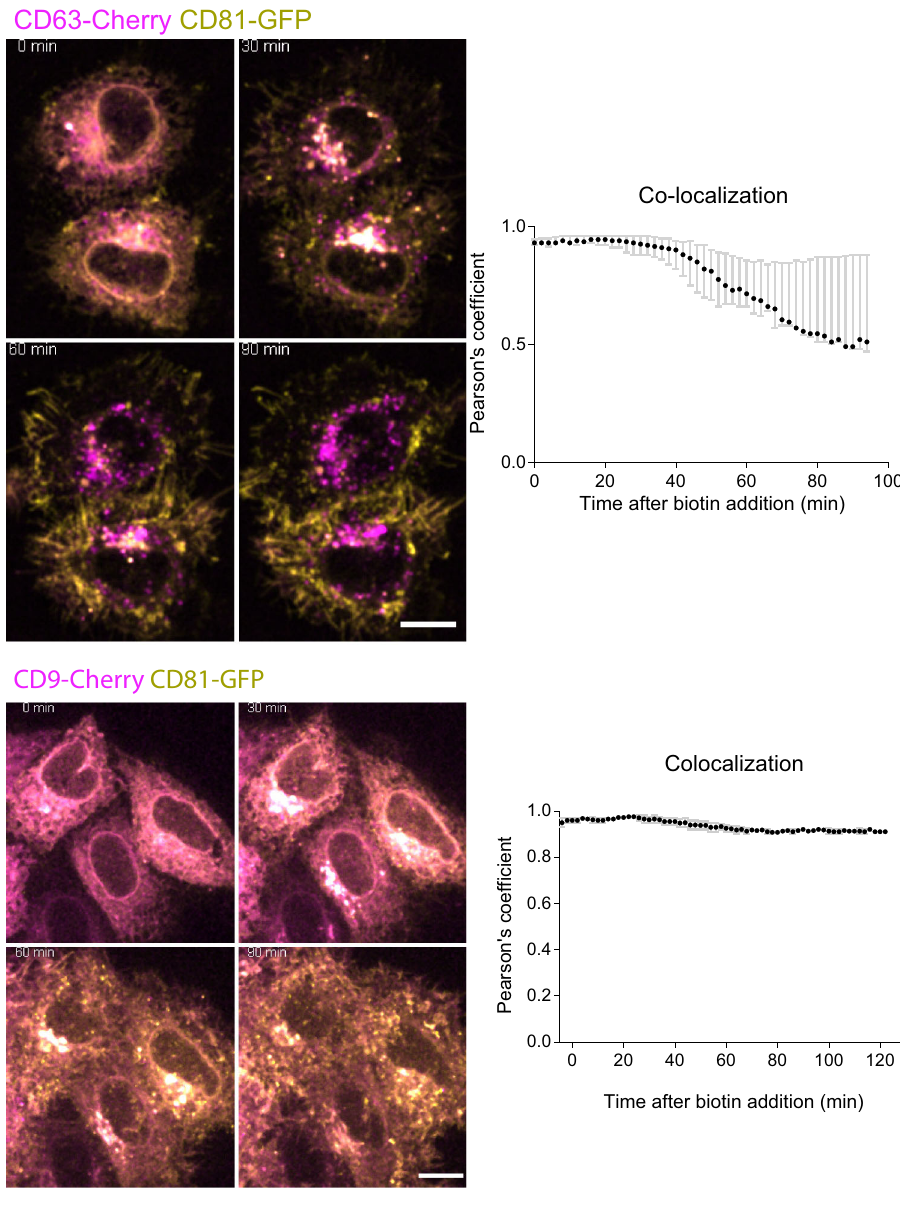
Fig. 8 Traf fi cking of RUSH-CD81 compared to RUSH-CD63 and -CD9. Micrographs of live imaging of HeLa cells co-transfected with either CD63-mCherry or CD9-mCherry and CD81-eGFP RUSH plasmids. Biotin was added at T = 0. The median ± range of the Pearson ’ s co-localization coef fi cient between eGFP and mCherry is represented over time after biotin addition. Scale bar: 10 μ m. 2 independent experiments. 5 fi elds per experiment where imaged, for a total of at least 10 cells to analyze per